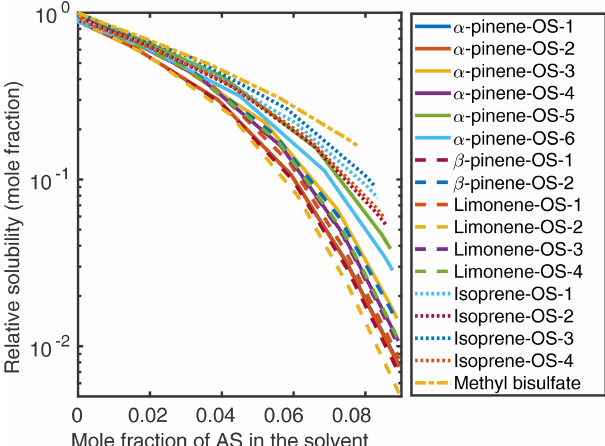
Figure 5. Relative solubilities of NaOS salts in ( NH 4 ) 2 SO 4 (aq) solutions ( T = 298 . 15K relative to pure water) estimated using rel- ative screening in COSMO therm